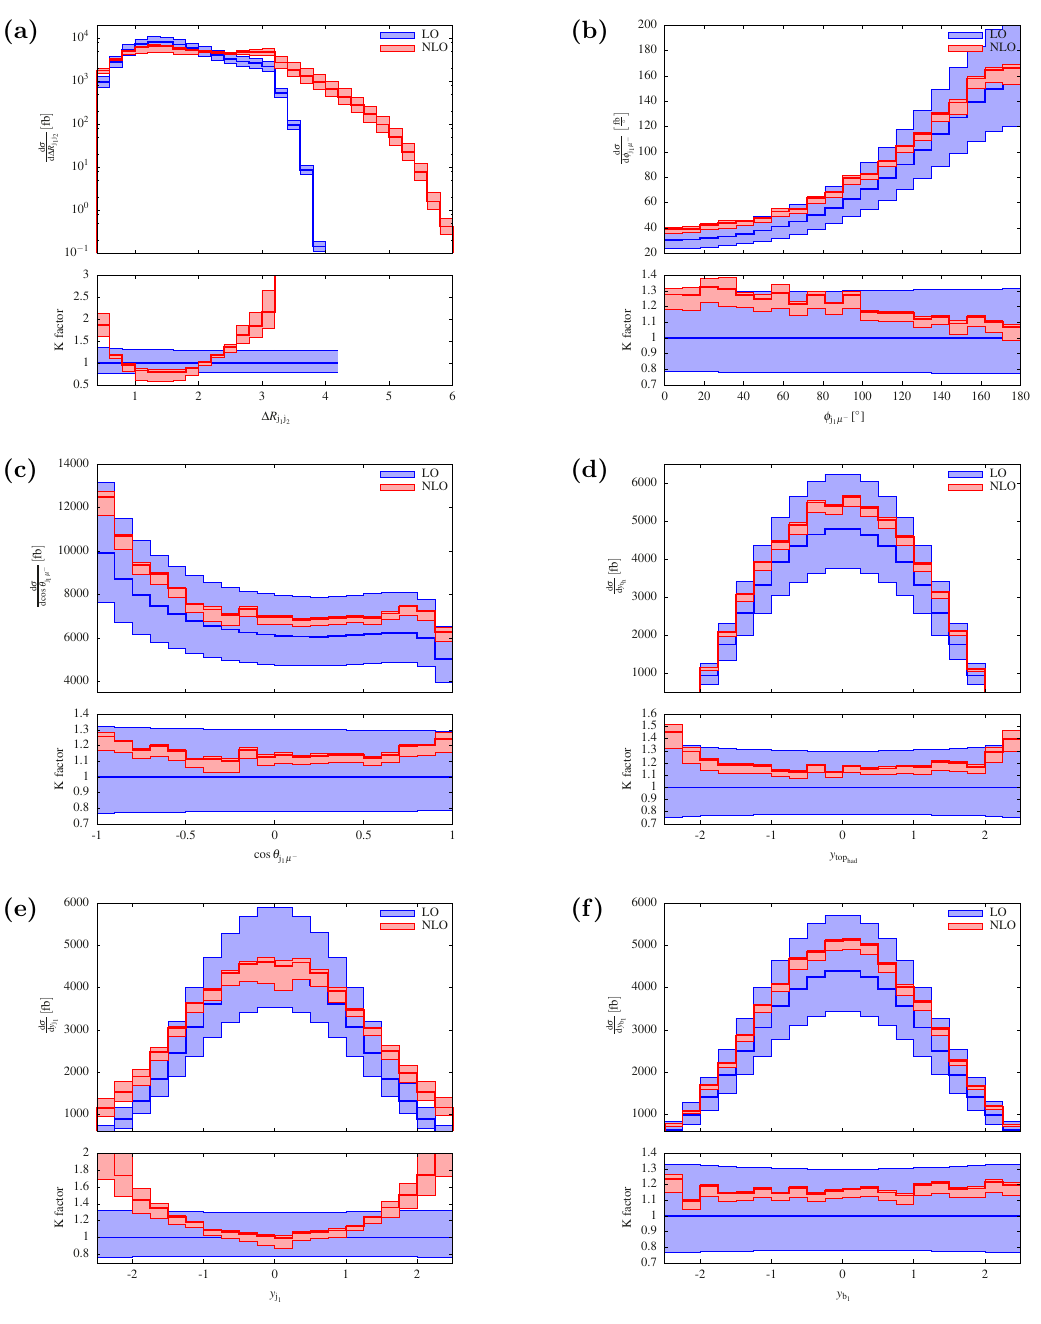
Figure 7. Di(cid:11)erential distributions at a centre-of-mass energy p s = 13 TeV at the LHC for pp (cid:22) (cid:0) (cid:22) (cid:23) (cid:22) b (cid:22) bjj: (a) rapidity-azimuthal-angle distance between the two hardest jets (top left), ! (b) azimuthal angle between the hardest jet and the muon (top right), (c) cosine of the angle between the hardest jet and the muon (middle left). (d) rapidity of the reconstructed hadronic top quark (middle right), (e) rapidity of the hardest light jet (bottom left), and (f) rapidity of the hardest bottom jet (bottom right). The upper panels show the LO prediction as well as the NLO one. The lower panels display the ratio of the NLO and the LO predictions. The bands correspond to factor-2 scale variations as de(cid:12)ned in eq. (4.9).